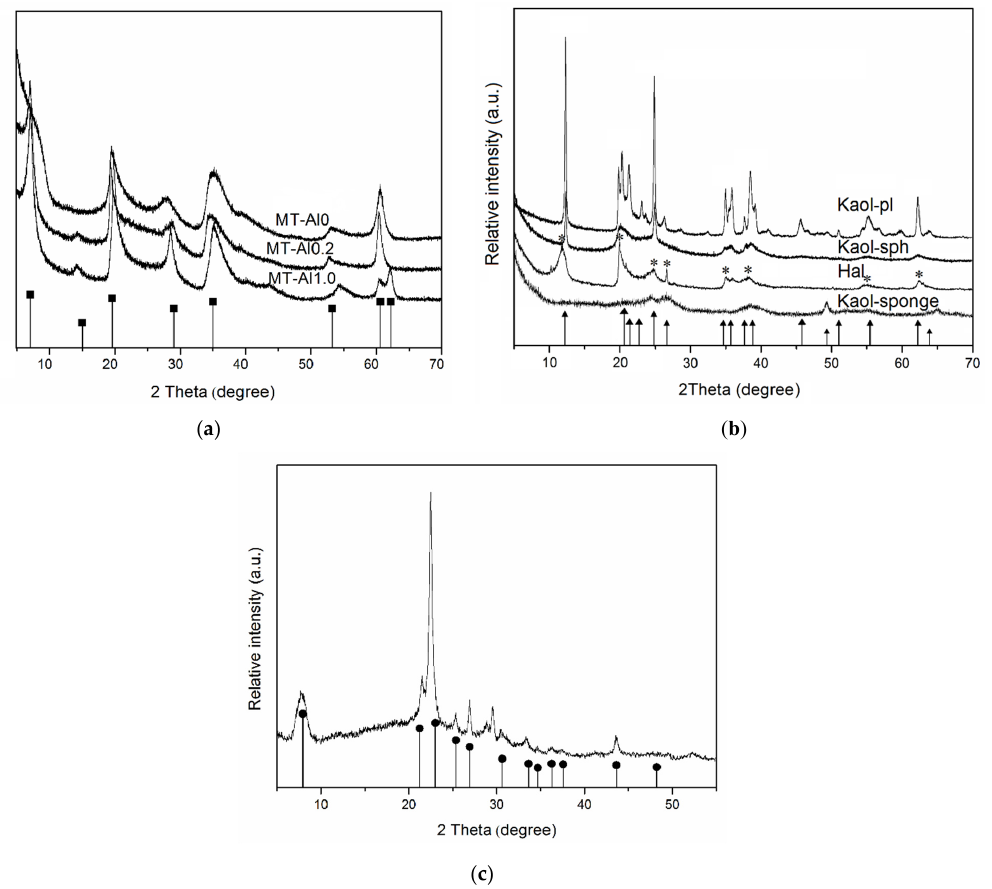
Figure 1. X-ray diffractions patterns of the samples: ( a ) aluminosilicates with montmorillonite structure; ( b ) aluminosilicates with kaolinite structure; and ( c ) zeolite Beta. Bar chart of the standards: ■ —raw montmorillonite (PDF No. 48-74); ▲ —raw kaolinite (PDF No. 79-1593); *—raw halloysite (PDF No 00–009-0453); ● —Beta (PDF No. 12-204).